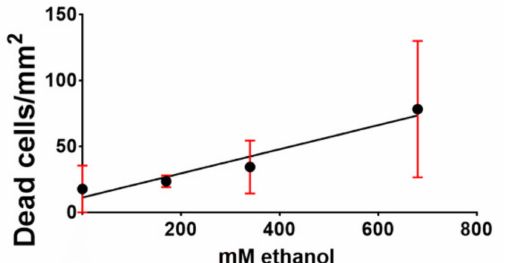
Figure 3. Linear regression curve of the density of dead cells related to di ff erent ethanol concentrations in culture media. Dead cells were stained with propidium iodide and results are expressed as means of dead cells / area. The curve demonstrates a positive correlation between the concentration of ethanol in medium and the density of dead cells. Slope was significantly non-zero: F = 30.55, p value = 0.0312. Equation: Y (dead cells / mm 2 ) = 0.09141 × (ethanol concentration) + 11.15. Bars indicate 95%